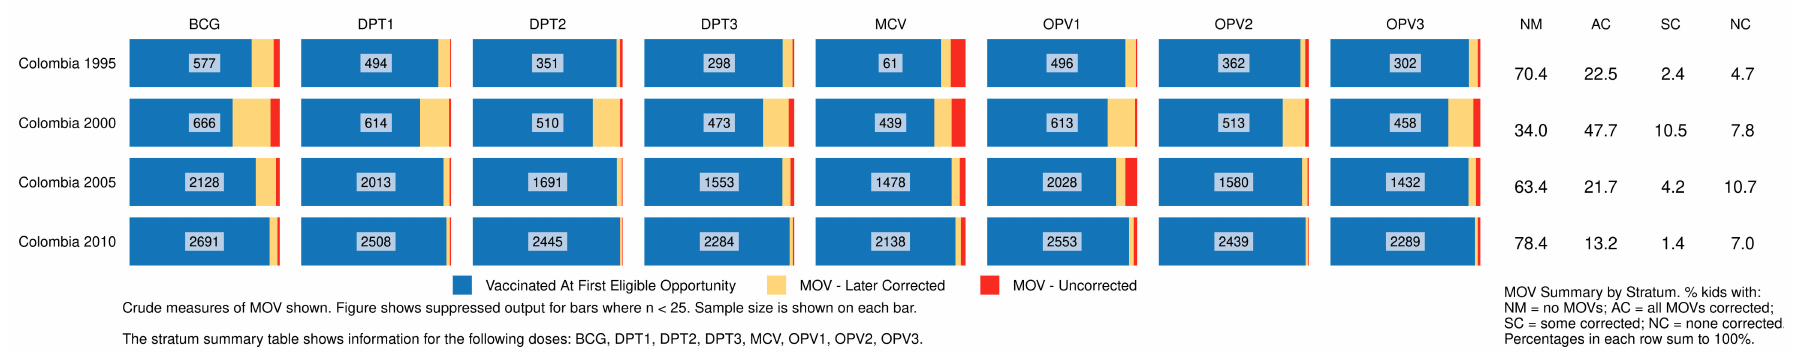
Figure 3. Proportion of children who experienced MOSVs & correction status at the time of survey, by dose, Nigeria 1990–2018. Detailed counts of children represented in each Figure 3 bar portion are documented in supplementary Table SN.3a.